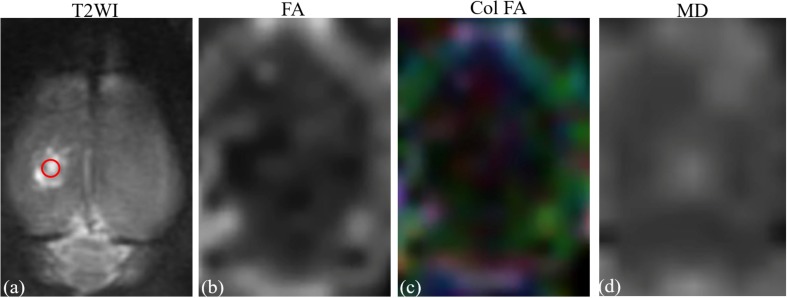
(a) T2-weighted image. (b) Fractional anisotropy map. (c) Color fractional anisotropy map. (d) Mean diffusion map. ROI of injury area (red circle in A) was chosen on axial T2-weighted image with which the fractional anisotropy map and T2-weighted image co-registered.